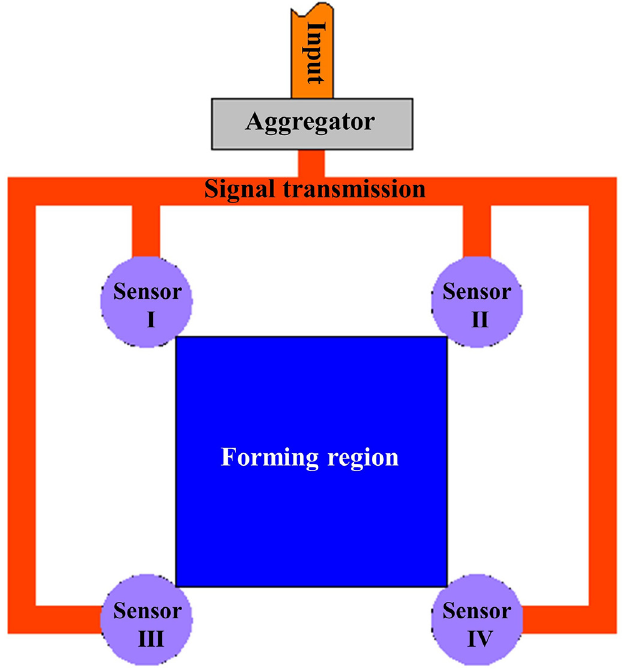
Fig. 4. Pressure sensor